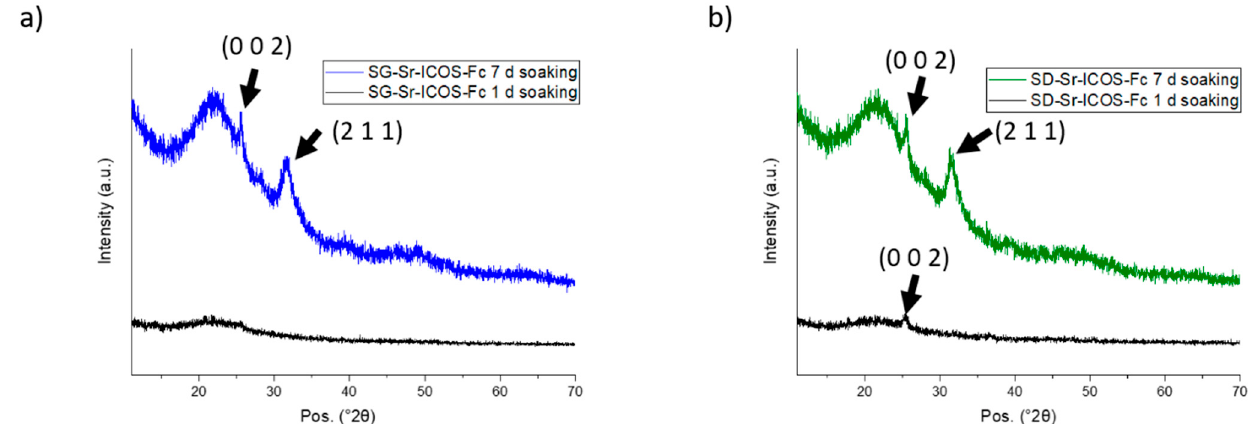
Figure 7. XRD at different time steps of soaking in SBF of SG-Sr-ICOS-Fc ( a ) and SD-Sr-ICOS-Fc ( b ).